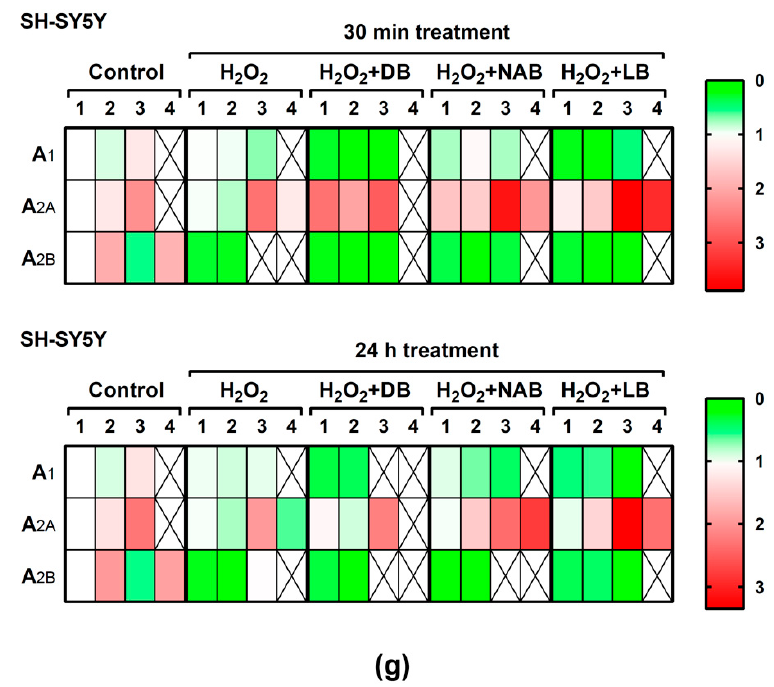
Figure 7. Adenosine receptors gene expression assayed by quantitative real-time RT-PCR in SH-SY5Y cells. After total RNA isolation, A 1 (panels a and b ), A 2A (panels c and d ), and A 2B (panels e and f ) gene expression levels were detected by TaqMan universal PCR following the protocol indicated in “Materials and Methods”. β -actin was used as an endogenous control in all assays. Treatments were performed for 30 min ( a , c , e ) and 24 h ( b , d , f ) with 50 µM hydrogen peroxide (H 2 O 2 ) and DB, NAB, and LB extracts in SH-SY5Y cells. ( g ) Heatmap of gene expression levels obtained in the analyzed samples. Data are means ± SEM of, at least, three independent assays; # p < 0.05, ## p < 0.01, and ### p < 0.001, significantly different from control (C) or considered bars according to one-way ANOVA test.